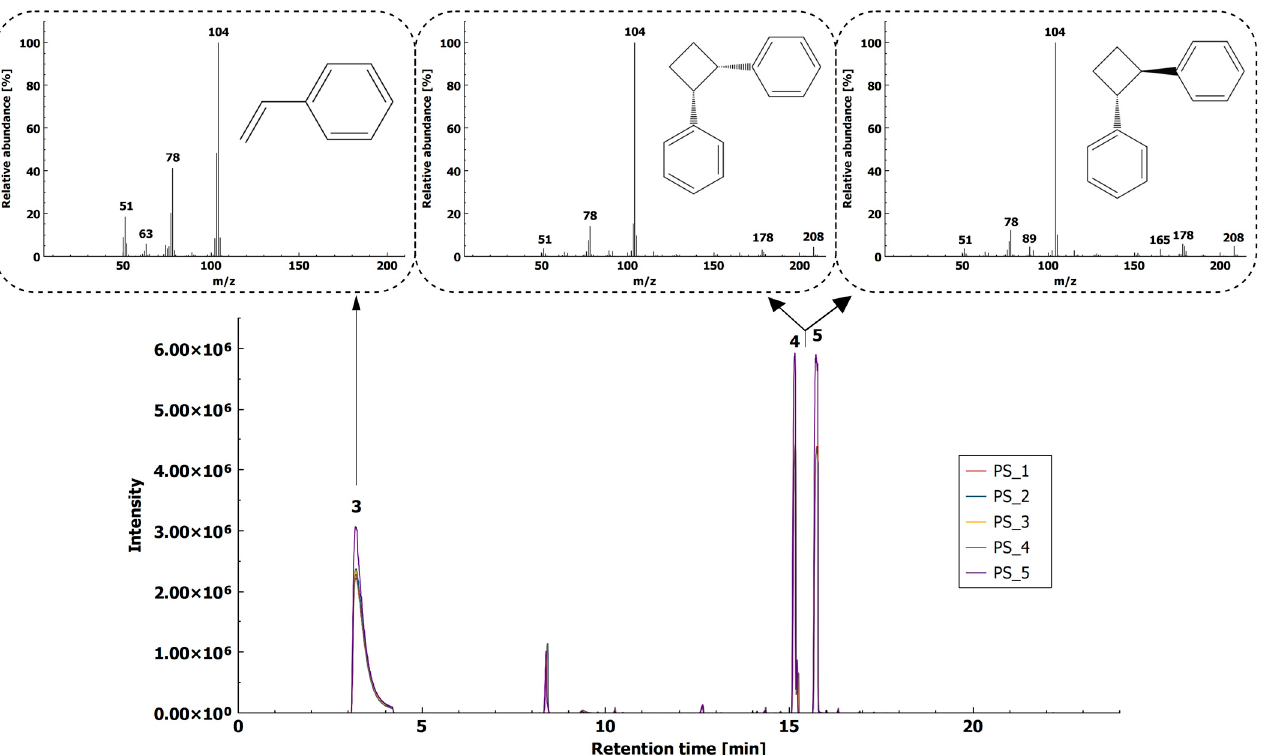
Figure 2. HS-SPME-GC–MS extracted ion chromatogram (XIC, m / z 104) of PS (5 replicates) with mass spectra of styrene (3) and trans ( cis )-1,2-diphenylcyclobutane (4 and 5).